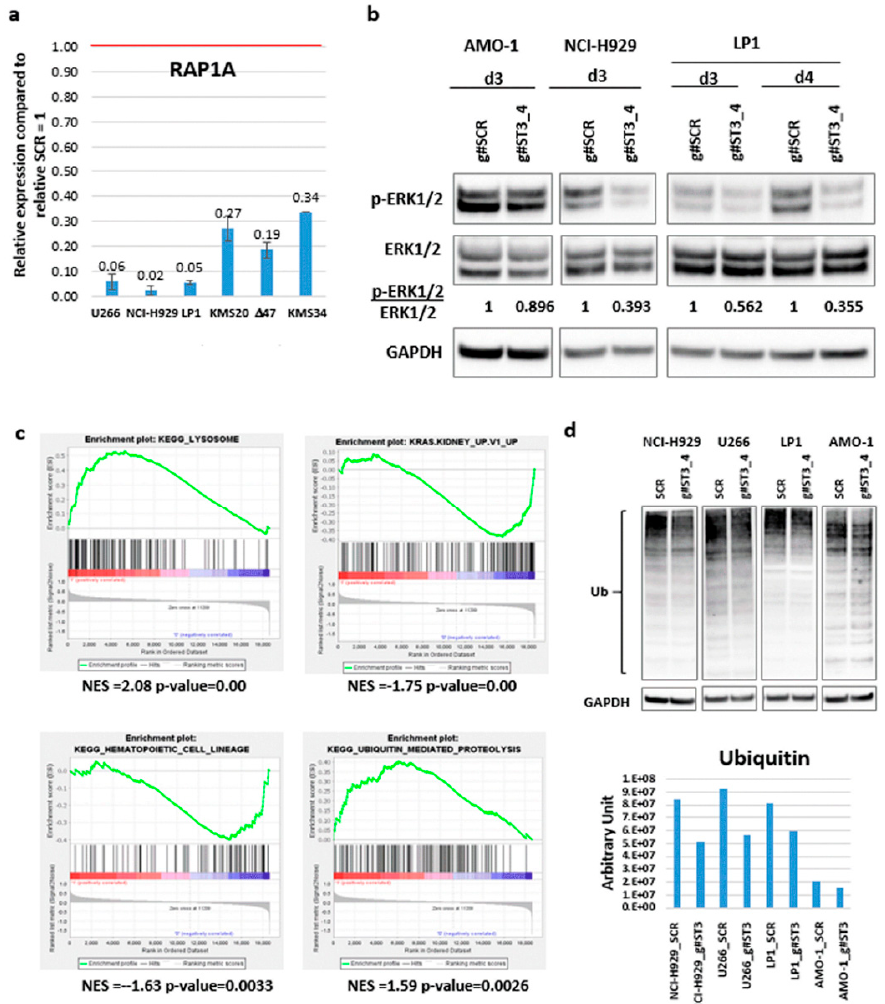
Figure 6. g#ST3_4 LNA-gapmeR effect on HMCLs. ( a ) RAP1A expression validation by RT-PCR. Mean and standard deviation on three replicates are reported. ( b ) WB of p-ERK1/2 and total ERK1/2 after delivery of g#ST3_4 gapmeR (5 μ M) at the indicated time points. HMCLs were cultured in FBS 1%. ( c ) Enrichment plots of four selected gene sets detected by GSEA. The green curves show the enrichment score and reflect the degree to which each gene (black vertical lines) is represented at the bottom of the ranked gene list. ( d ) WB of ubiquitin after treating the indicated HMCLs with g#ST3_4 gapmeR (5 μ M, 3 days); densitometric evaluation is reported in the histogram below.